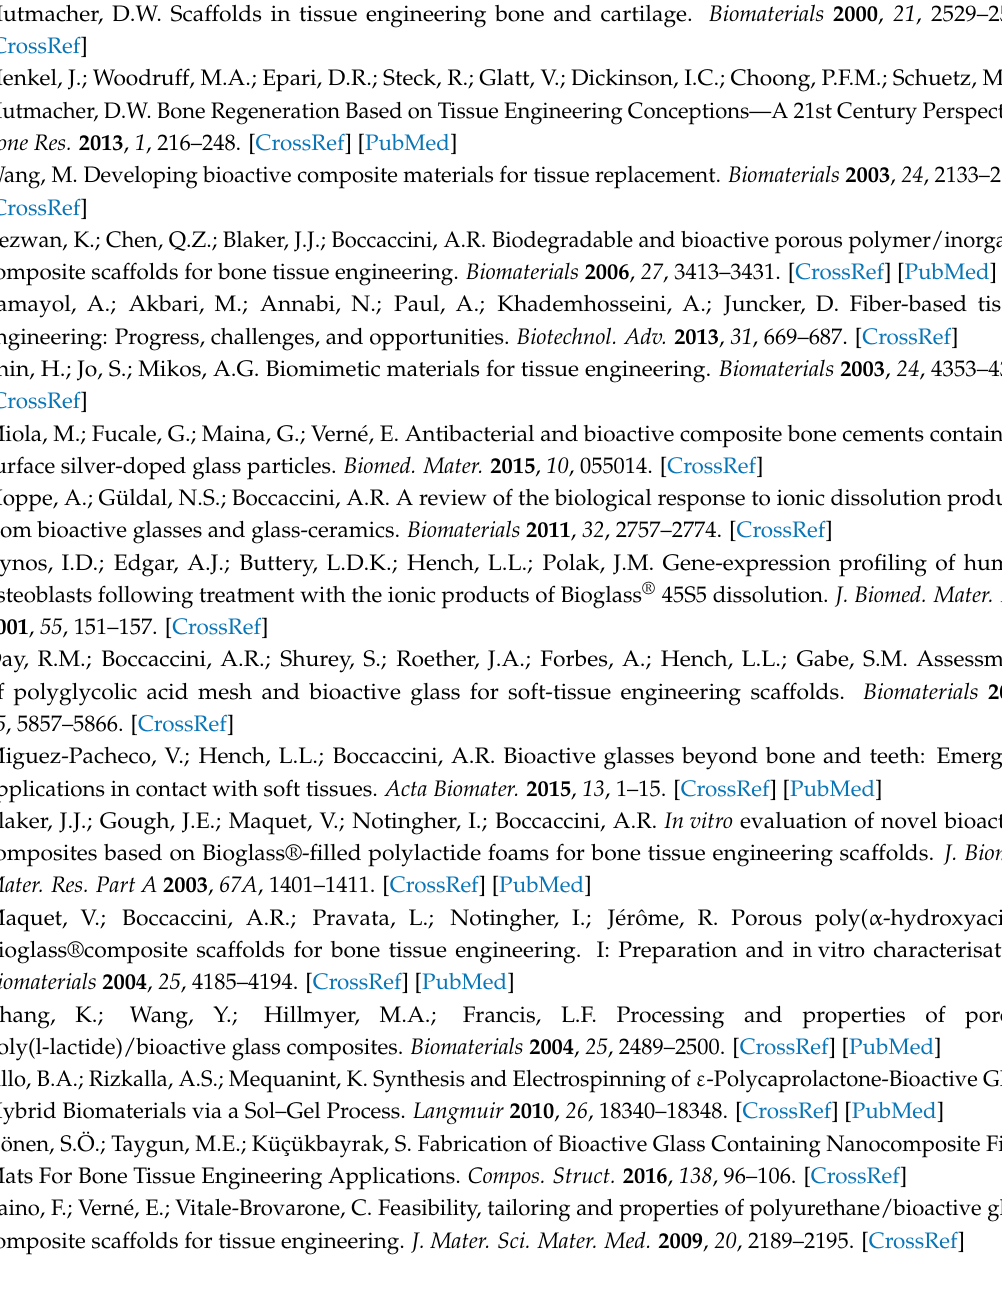
Figure S1: EDS analysis performed on PLLA-SBA2 sample before (top) and after 21 days of immersion in SBF solution (bottom), Figure S2: SEM micrographs of neat PLLA fibers (a), composite PLLA-SBA2 fibers (b), composite fibers after 7 days in DPBS (c) and 21 days in SBF